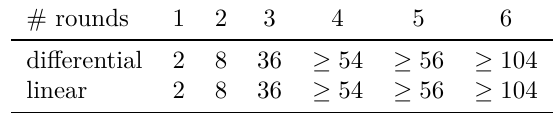
Table 7: The weight of the best differential and linear trails (or lower bounds) as a function of the number of